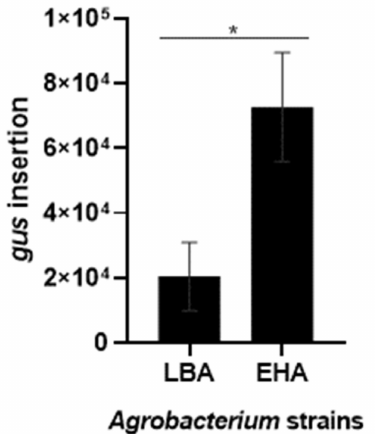
Figure 6. Quantification by qPCR of the gus insertion in tamarillo embryogenic callus genetically transformed by the Agrobacterium -mediated method using LBA4404 (LBA) and EHA105 (EHA) strains. Data were normalized using ACT as the reference gene. Results are presented as the mean ± SEM of four biological replicates. * indicates significant differences by t -test at p <